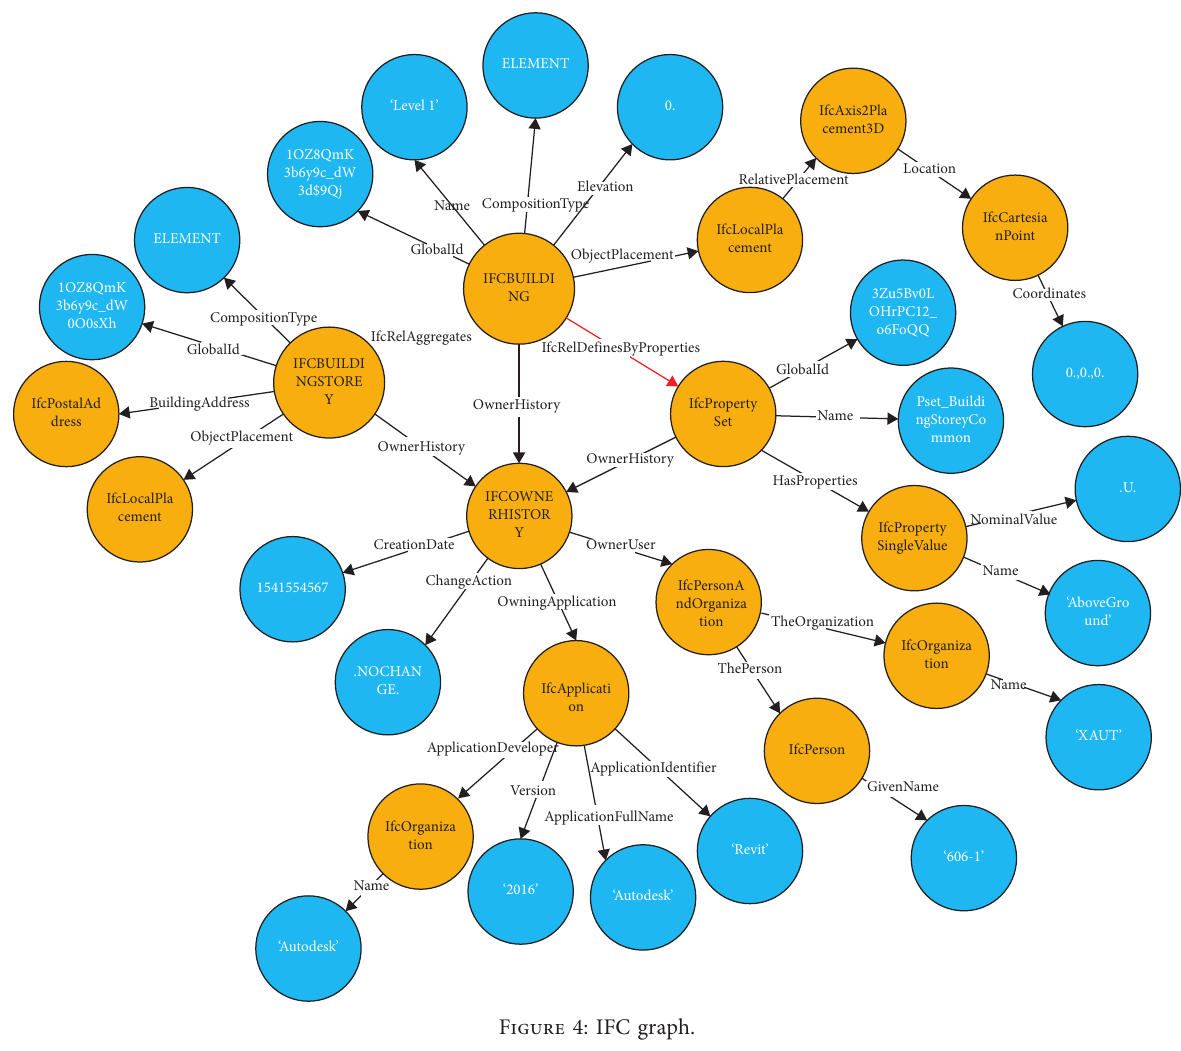
Figure 4: IFC graph.